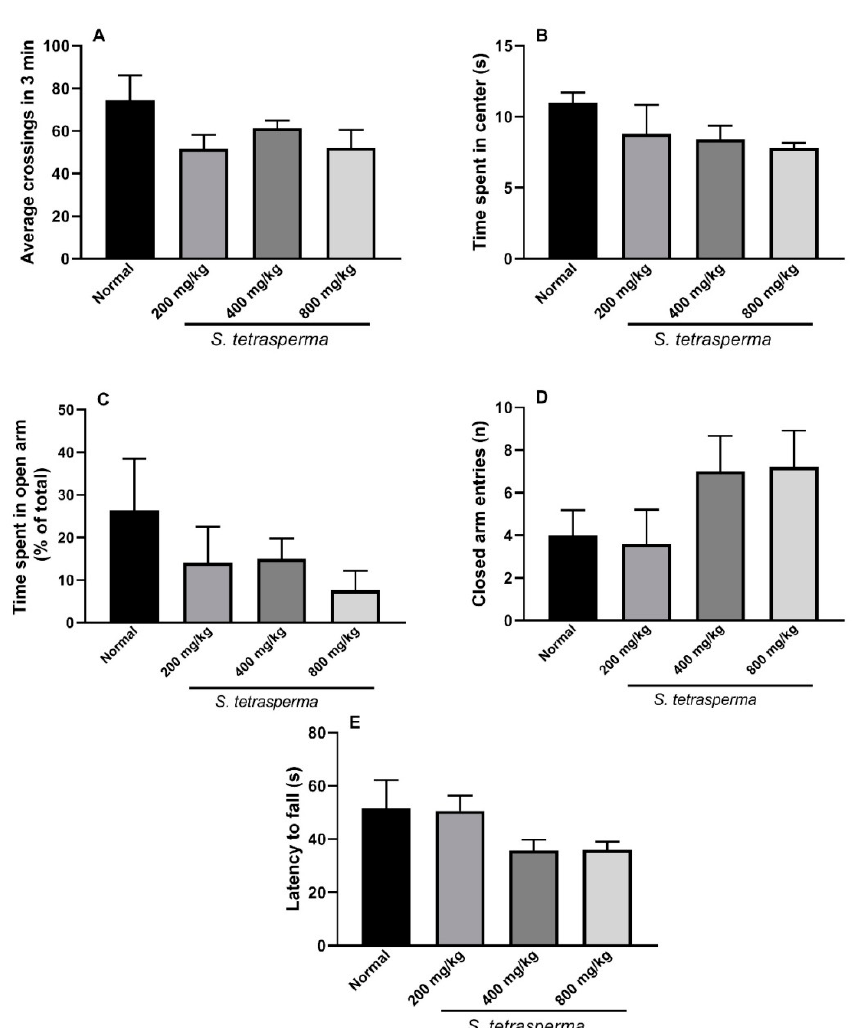
Figure 8. E ff ect of S. tetrasperma extract (200, 400 and 800 mg / kg, p.o) on: ( A , B ) open field activity total number of crossings and time spent in center, respectively; ( C , D ) elevated plus maze test time spent in open arm and number of closed arm entries, and ( E ) rotarod test latency to fall measurement. The values are expressed as the means ± SEM ( n = 5–6).